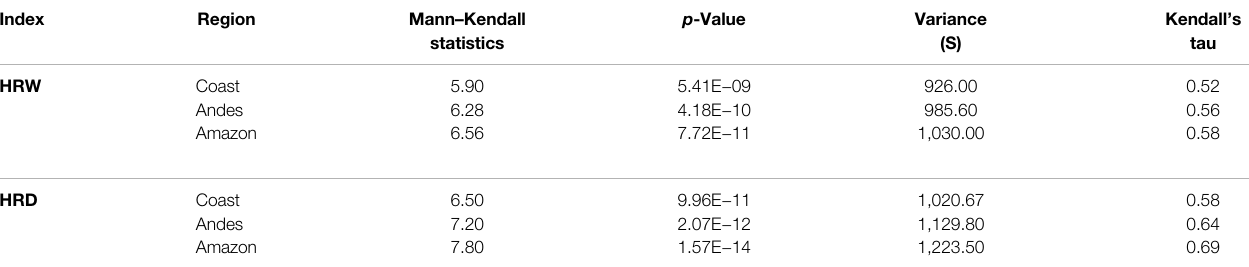
TABLE 3 | Results of the Mann – Kendall model for the mean of the indices derived from the CSIRO model for all